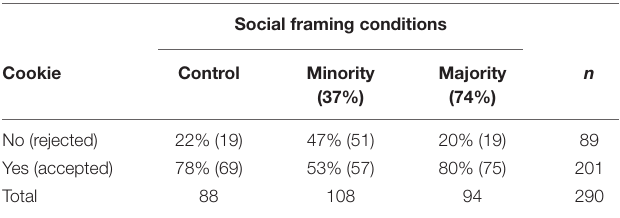
TABLE 1 | Cookie responses based on social group references (percentages reflect distribution of participants by condition). Social framing